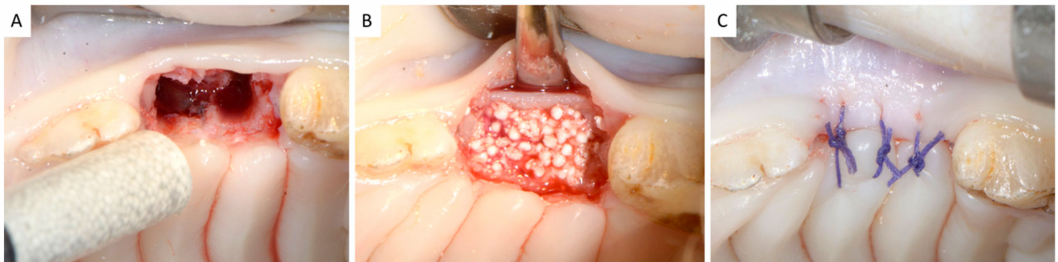
Figure 2. ( A , B ) The experimental sites were grafted with the resorbable alloplastic in situ hardening bone substitute; ( C ) All sites were closed without